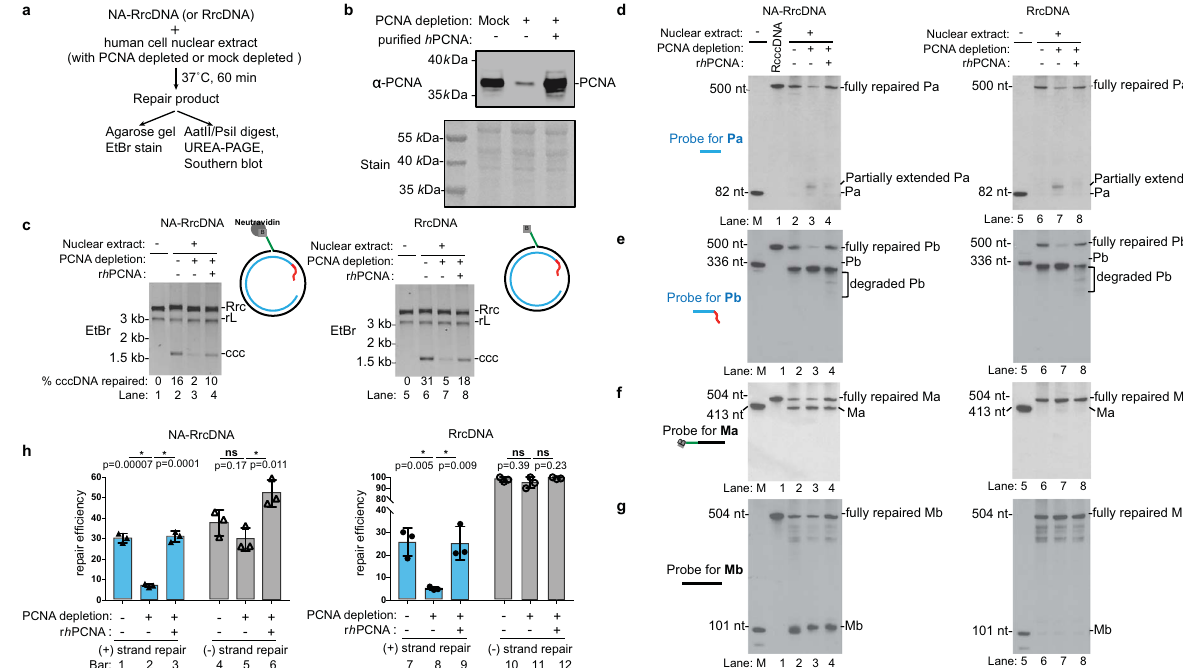
Fig. 5 Immunodepletion of PCNA from human nuclear extracts diminished plus strand repair. a Schematic of cccDNA formation assays to test the effects of PCNA depletion in human nuclear extracts on the repair of the plus and the minus strands. b PCNA levels in mock-depleted or immunodepleted human nuclear extracts were determined by western blotting. Stain, Ponceau S stain. c The depletion of PCNA diminished the cccDNA formation ef fi ciency of NA-RrcDNA (lanes 1 – 4) and RrcDNA (lanes 5 – 8) in human nuclear extracts. The percentage of cccDNA formed was calculated as in Fig. 2c. d – g Repair of plus-strand fragments Pa, Pb, and minus-strand fragments Ma, Mb was monitored by Southern blot, as shown in Fig. 2d – g. Left panel, repair of NA- RrcDNA; right panel, repair of RrcDNA. h Repair ef fi ciency of plus-strand e and minus-strand f was calculated as in Fig. 2i, and plotted. Statistical analyses between pairs of conditions were performed by two-stage step-up t test method from Graphpad Prism. All experiments were repeated three times. The bar values indicate the average of three measurements and the error bars are the s.d. P values are 0.00007, 0.0001, 0.17, 0.011 for repair of NA-RrcDNA between indicated pairs; whereas P values are 0.005, 0.009, 0.39, and 0.23 for repair of RrcDNA between indicated pairs. Statistical signi fi cant p values are indicated by “ * ” . Rrc, RrcDNA; rL, recombinant linear RrcDNA; Rccc, recombinant cccDNA. Source data are provided as a Source Data fi